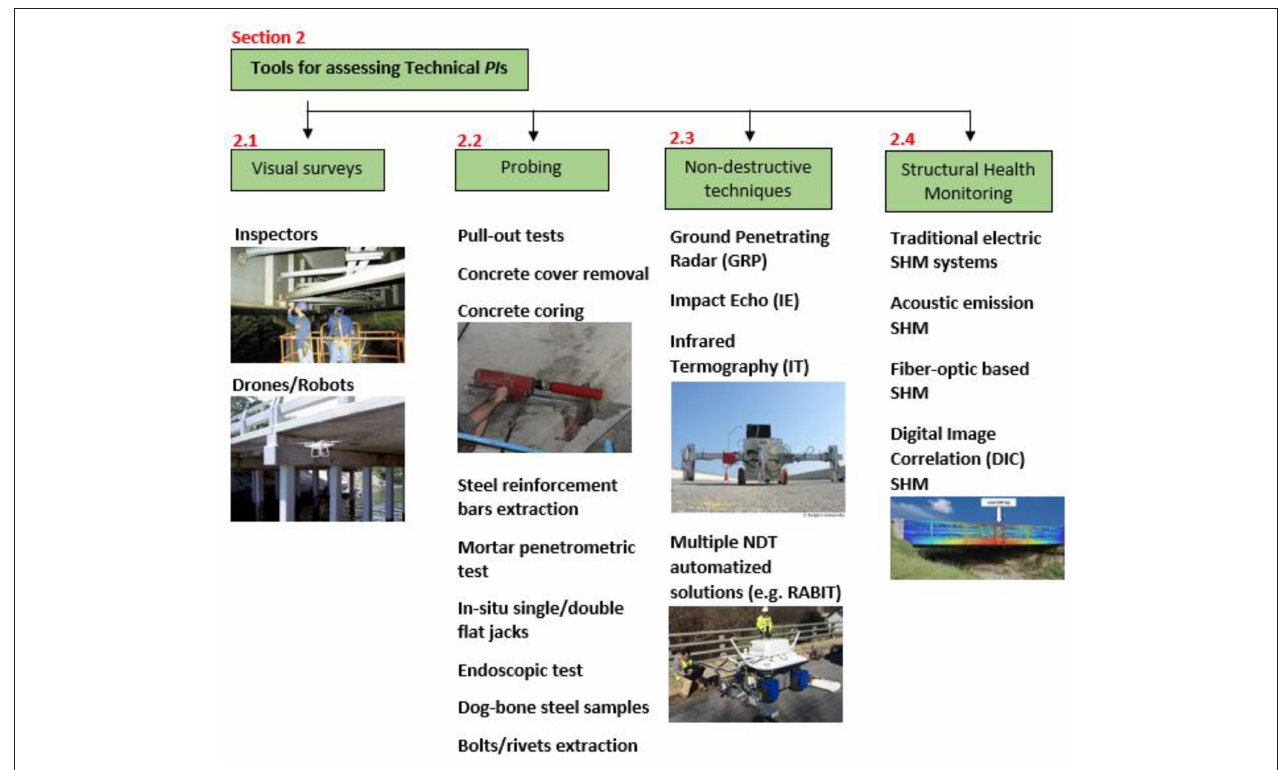
FIGURE 2 | Sketch of the tools currently in use for the assessment of technical PI